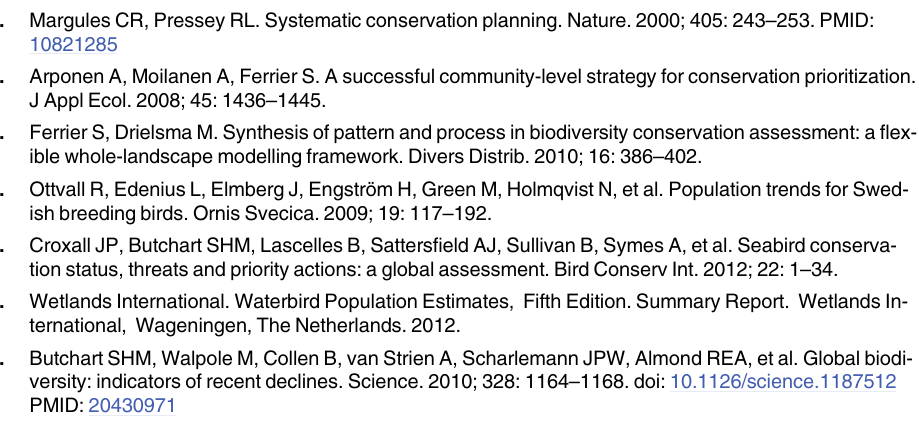
S1 Table. Correlations between differences in red-listed coastal breeding bird communities and differences in environmental variables. r values, estimated by partial Mantel tests, are the correlation of Sørensen ’ s dissimilarity index with the distance matrices for the explanatory var- iables, as estimated by partial Mantel tests. P indicates statistical significance. Communities were defined as All red-listed species, Red-listed specialist species (i.e. red-listed bird species breeding only in the archipelago) or Red-listed generalist species (i.e. red-listed bird species breeding in the archipelago but also in inland